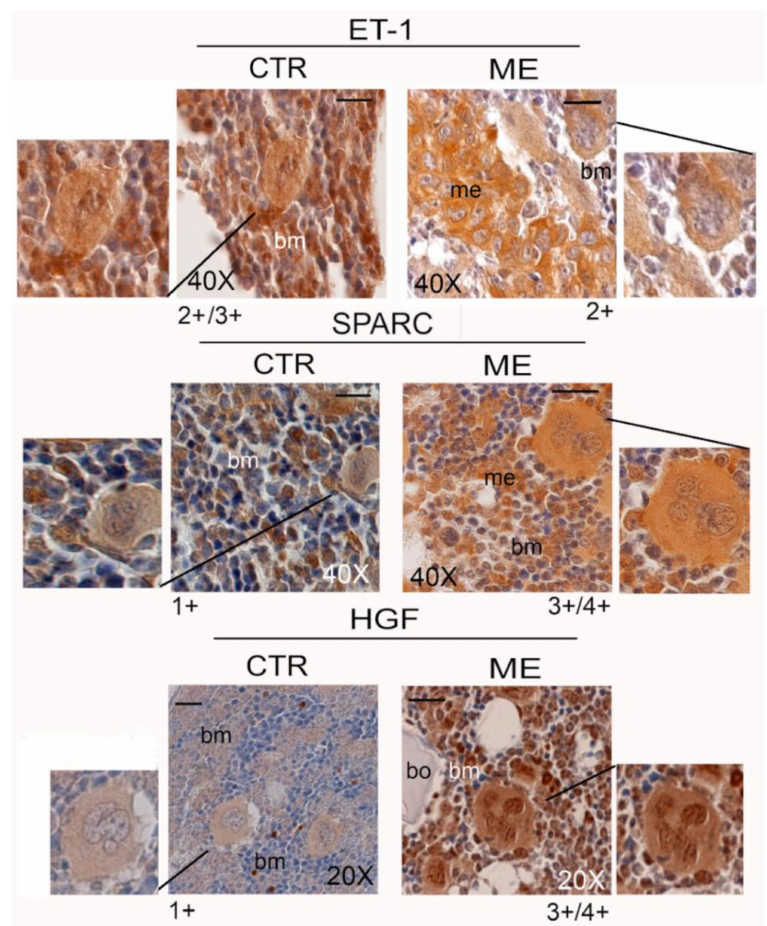
Figure 3. Positive reaction of MKs for endothelin-1 (ET-1), SPARC, and hepatocyte growth factor (HGF) in the bone marrow of femurs of control (CTR) and bone metastasis-bearing mice (ME). Representative images are shown, and three serial sections were analysed ( n = 3). Semi-quantitative analysis of MK immunostaining is given below each panel: 4+ denotes very strong staining; 3+ strong staining; 2+ moderate staining; and 1+ weak staining. Statistical analysis is reported in